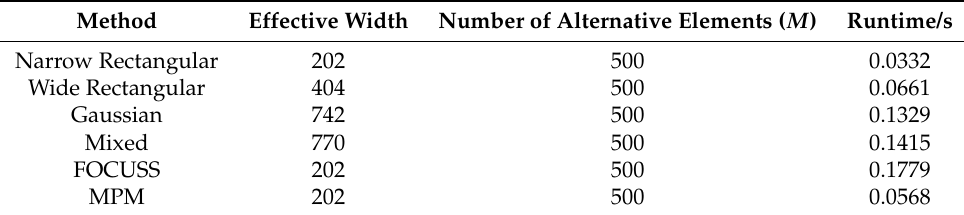
Table 2. The runtime of each method in Simulation